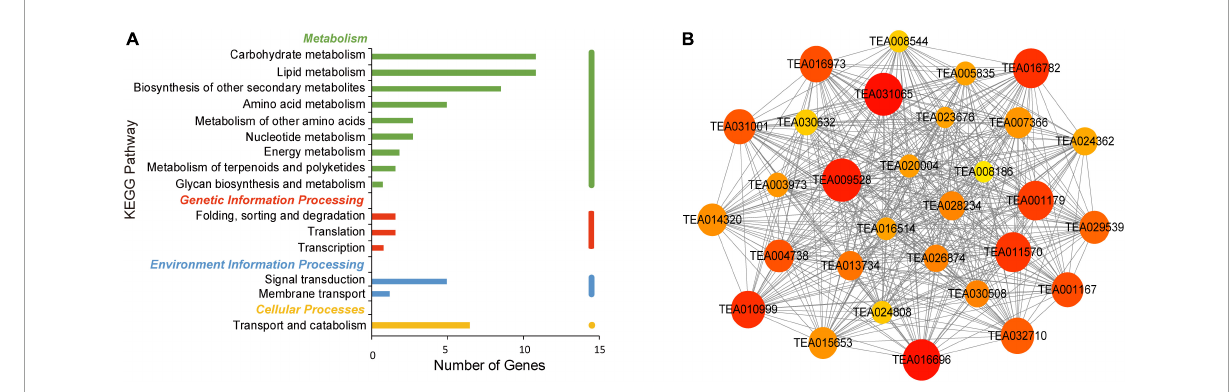
FIGURE8 KEGG pathway analysis and network diagram associated with the brown module. (A) KEGG pathway annotation of genes in the brown module. The genes with higher weight are shown in red, and the size of the node represents the number of genes associated with the node. (B) Gene networks of hub genes of the brown module.